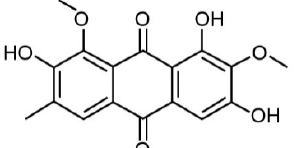
Figure 1. Structural formula of Aurantio-obtusin.